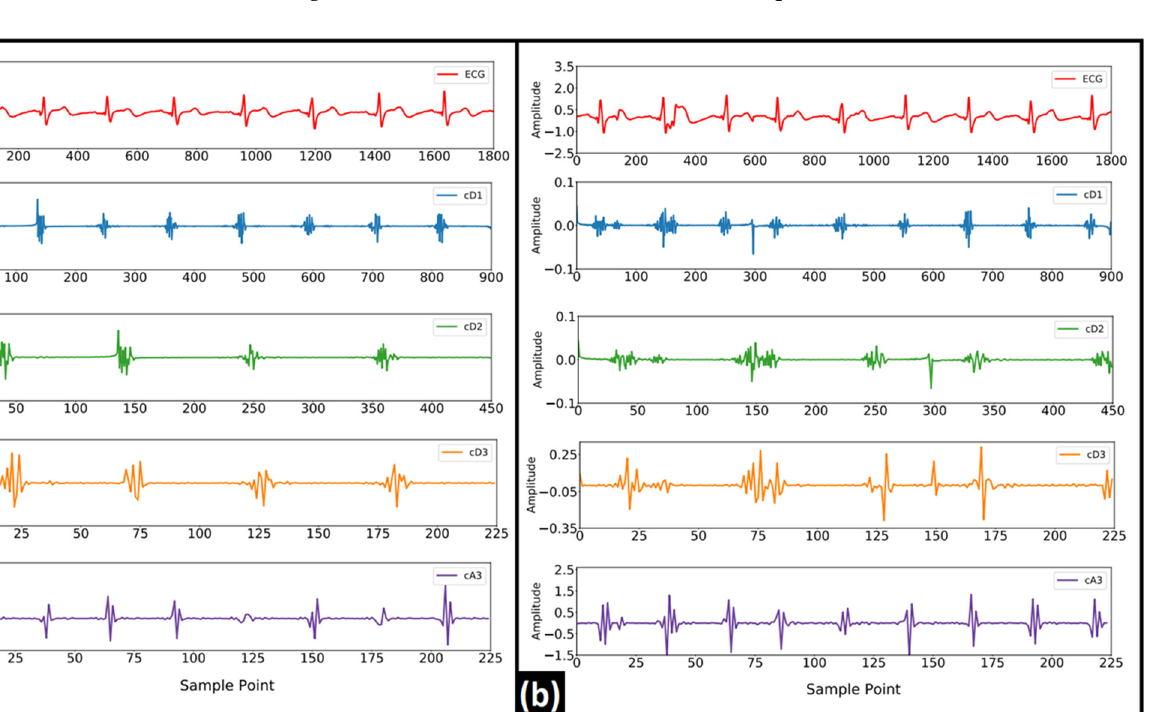
9 of 22 NB: Color scale used in the table (column-wise): minimum value maximum value. 3.2. DWT Analysis The DWT-based decomposition was performed on each of the 5 s ECG signals using a range of decomposition levels (levels: 2 – 5) and Daubechies mother wavelets (db2, db4, db6, and db8). A representation of the obtained decomposed signals after level-4